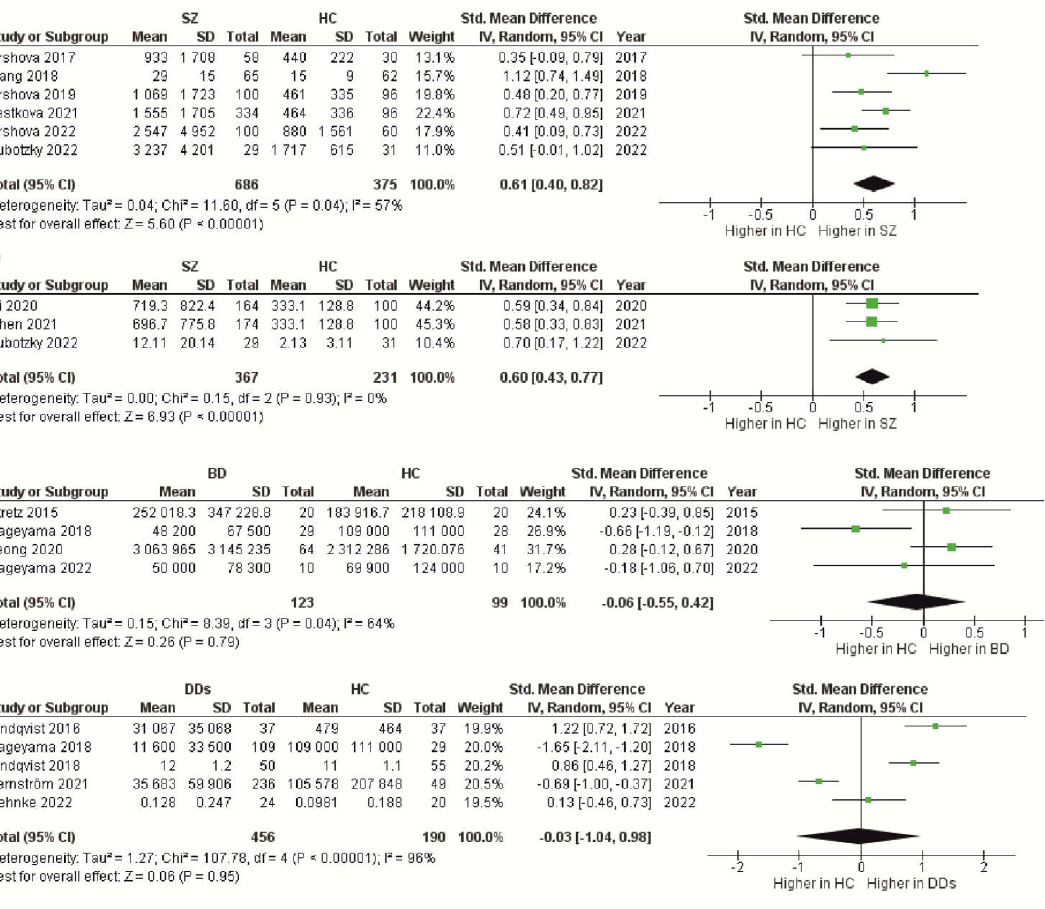
Figure 2. Forest plot showing plasma and serum levels of total cfDNA in patients with schizophre- nia ( a ), cf-gDNA in schizophrenia ( b ), cf-mtDNA in BD ( c ), and cf-mtDNA in DDs ( d ) compared with healthy controls. BD—bipolar disorder; CI—confidence interval; DDs—depressive disorders; SD—standard deviation; SZ—schizophrenia; HC—healthy